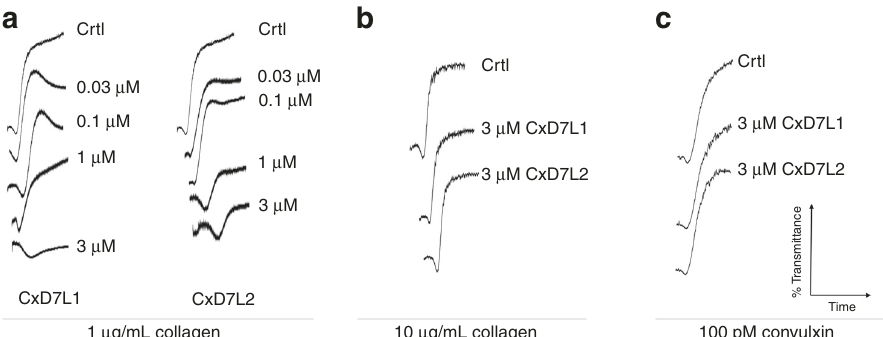
Fig. 6 Effect of CxD7 proteins on platelet aggregation induced by collagen or convulxin. Prior to the addition of the agonist, platelet-rich human plasma was incubated for 1 min with either PBS (Crtl) or with the recombinant proteins at the concentrations shown. Aggregometer traces were measured at 37 °C from stirred platelets suspensions on a Chrono-Log platelet aggregometer model 700 for 6 min. An increase of light transmittance over time indicates platelet aggregation. a CxD7L1 and CxD7L2 concentration-dependent inhibition of platelet aggregation induced by low doses of collagen (1 µ g/mL). CxD7L1 and CxD7L2 failed to inhibit platelet aggregation induced by b high doses of collagen (10 µ g/mL) and c GPVI agonist convulxin (100 pM). Graphs are representative of two measurements. Source data are provided as a Source Data fi